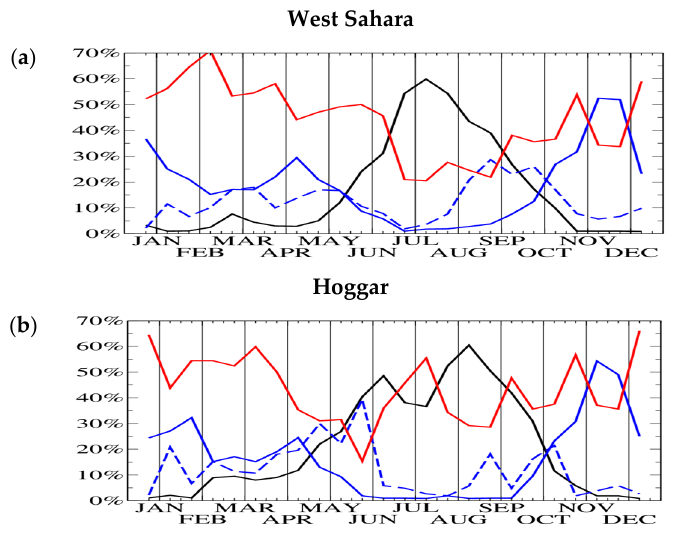
Figure 7. ( a ) Frequencies of mid-top days, high-top days and clear days for West-Sahara. ( b ) Frequencies of mid-top days, high-top days and clear days for Hoggar. For the 2008–2014 period and 15-day